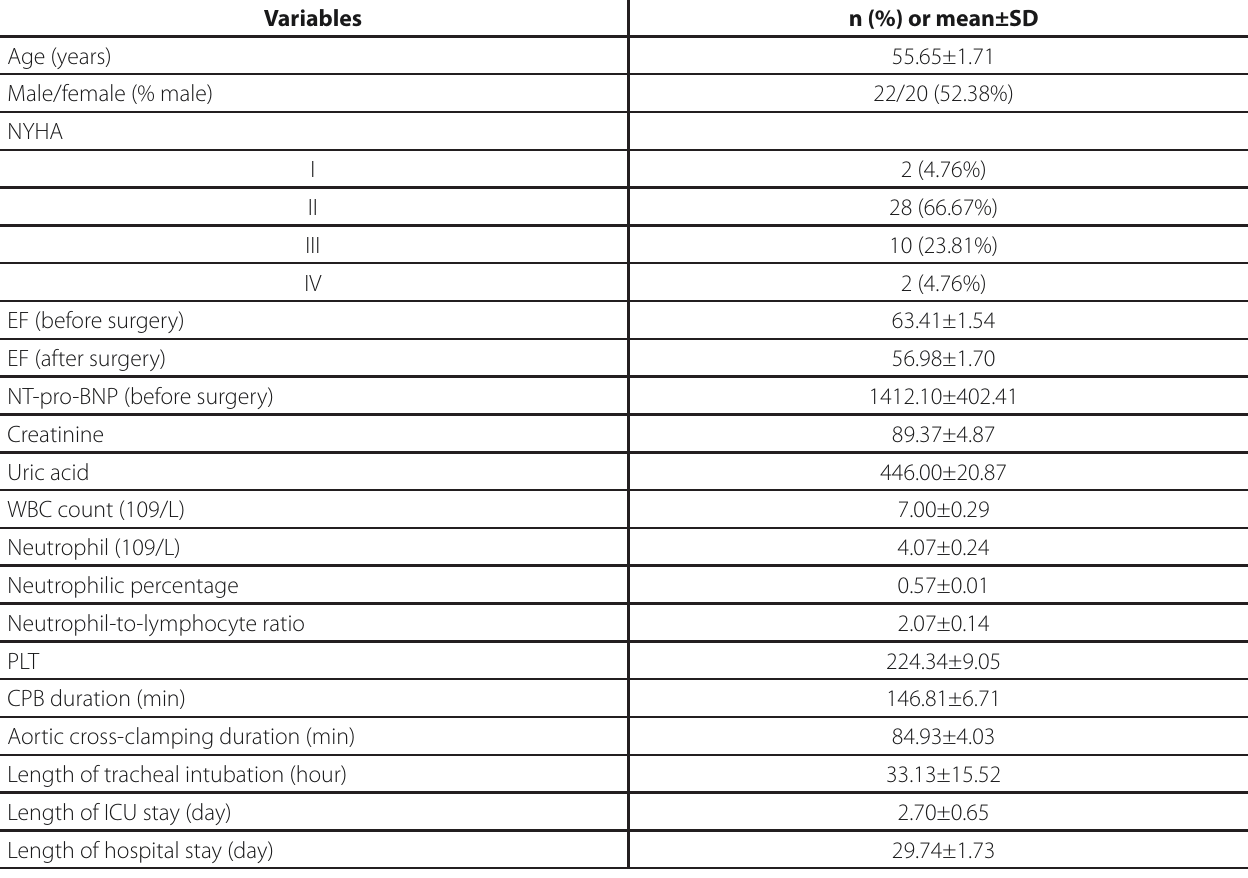
Table 1. Clinical characteristics of VHD patients (n=42).